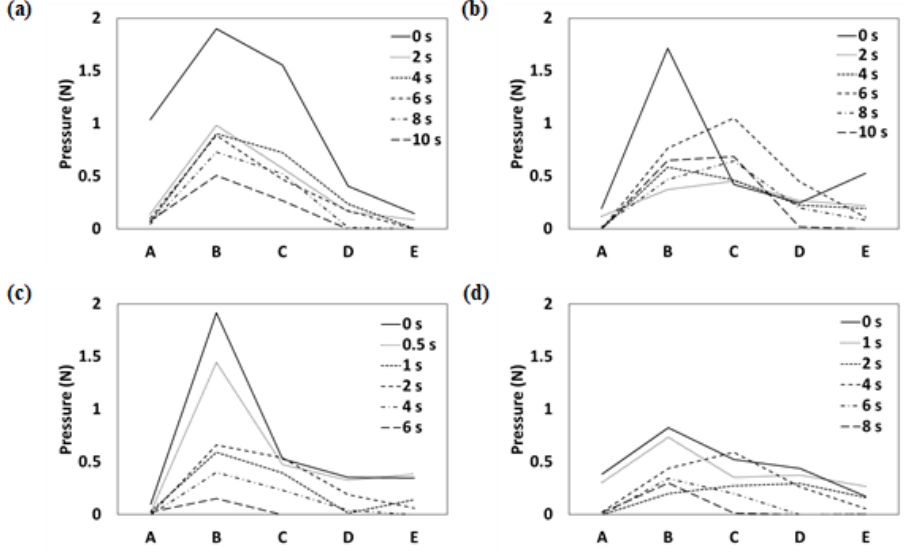
Figure 9. Wall pressures measured at different locations on the silo wall during discharging of soy- beans with different moisture contents: ( a ) 12% and 40 mm orifice, ( b ) 40% and 40 mm orifice, ( c ) 40% and 60 mm orifice, and ( d ) 60% and 60 mm